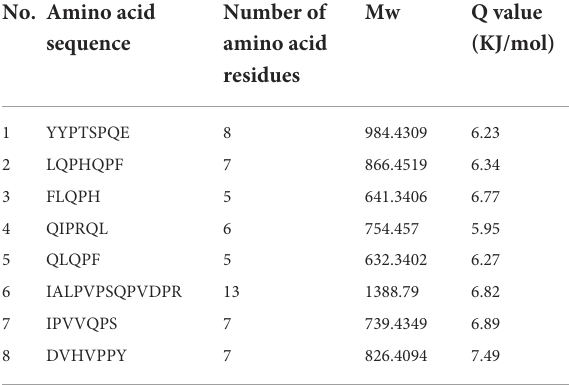
TABLE 4 Result of peptides sequence of WGH-Alc12M determined by